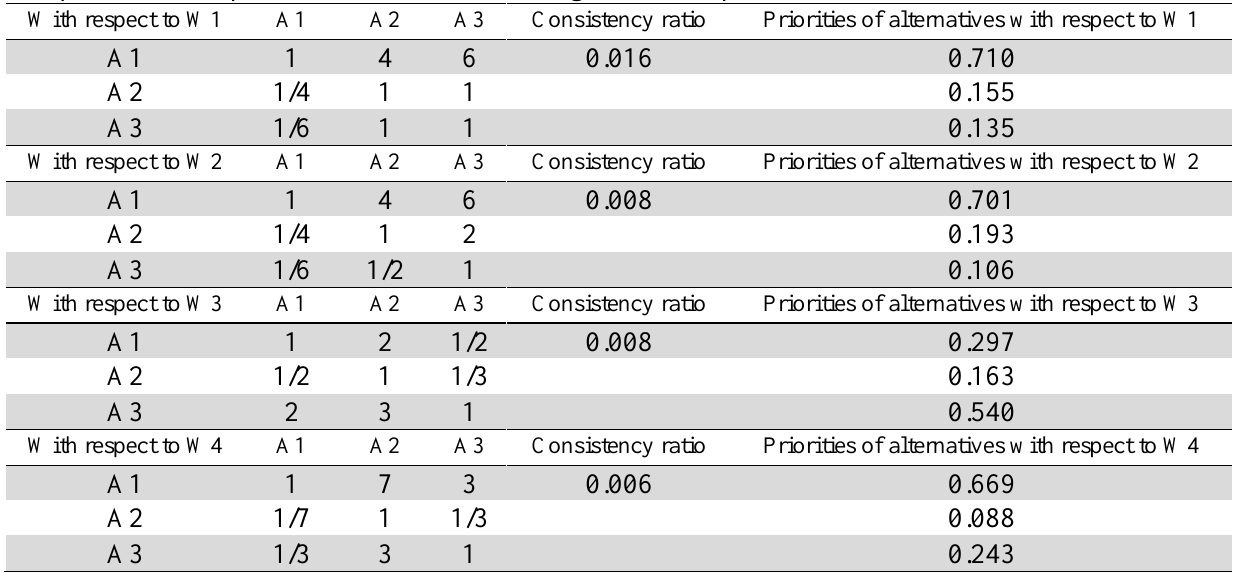
The pair-wise comparisons of alternative strategies with respect to the weakness factors With respect to W1 A1 Consistency ratio